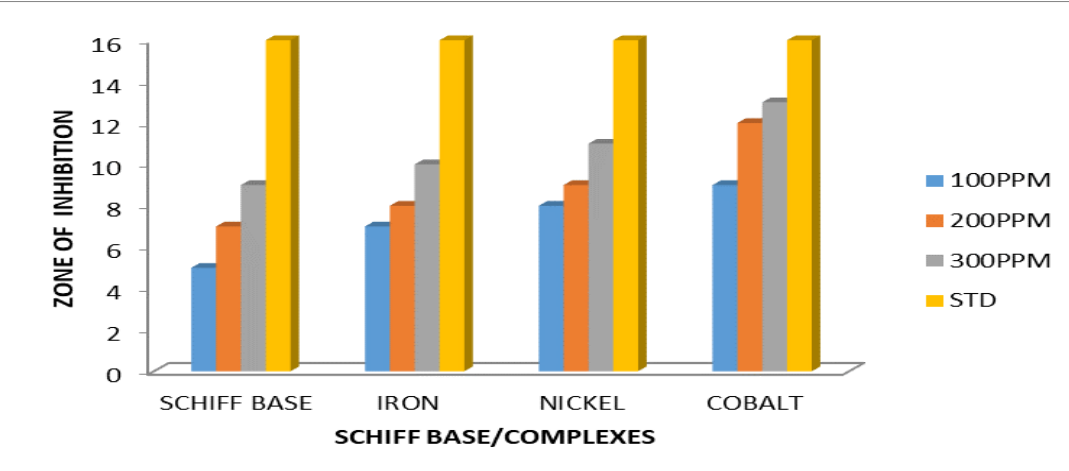
Figure 4. Sensitivity test for antibacterial activity of schiff base and its metal (II) complexes against clinical isolate ( Klebsiella pneumoniae ) using well diffusion